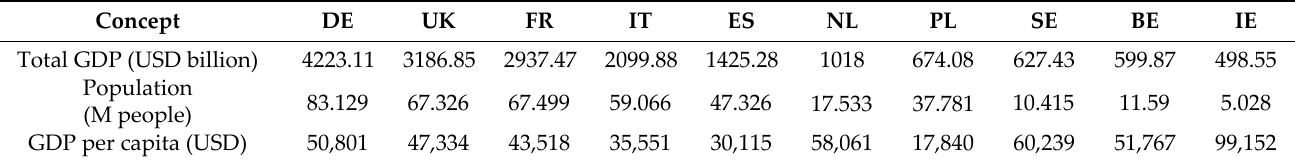
Table 2. Top ten European countries ranking by total GDP (2022